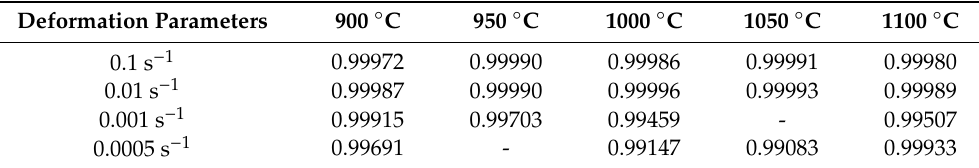
Table 2. The correlation coefficients between measured and predicted values.